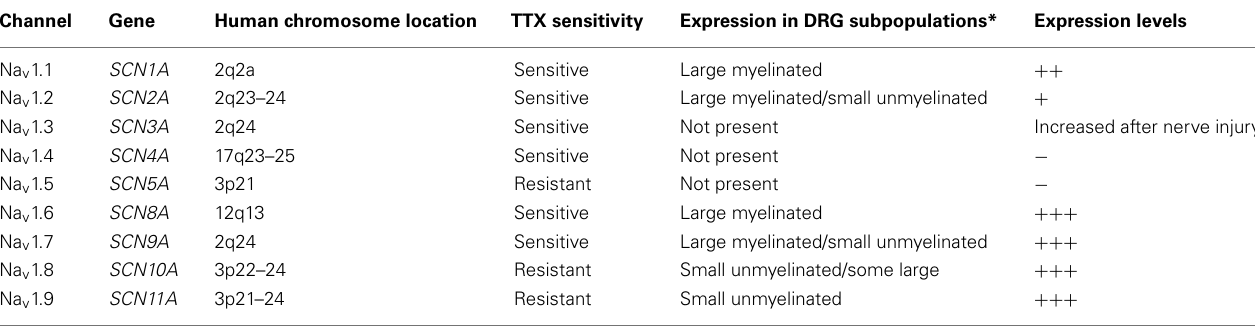
Table 1 | Gene location and distribution of Na channels α subunits in subpopulations of DRG sensory neurons. Channel